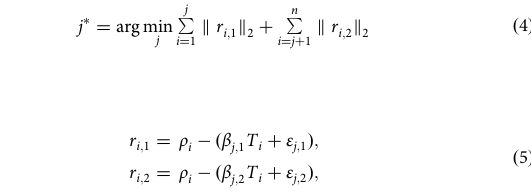
Supplementary Table 1. For the viscosity, a correlation time of 1 ns was used and the simulations were run for 500 ns. Further validation of the force fi eld was done by comparing histograms and RDFs of HDDA to ab-initio based MD as implemented in the CP2K software 62 . The ab initio simulations were performed using the BLYP functional supplemented with D3 dispersion corrections 25,63 . As shown in Supplementary Figs. 1 and 2, the histogram of the dihedral angles of HDDA in liquid state and the end-to-end distance in HDDA are well-captured by the TraPPE-UA force fi eld with a few notable differences. In addition, the RDFs of the 1-1 and 2-2 reactive sites are also well-captured by the employed force fi led in comparison to the ab initio simulations as shown in Supplementary Fig. 3. Curing simulations . We used a simulation protocol that accelerates the curing process by lowering activation energies and increasing temperature to 600 K, which was earlier shown not to affect the structure of the network when considered as a function of bond conversion 15 . The covalent bonds appearing during the curing of the network were created using a reactions cutoff radius of 4 Å . The proximity of reactive sites was checked every 10 fs and a bond was created with probability 0.5 for every time reactive sites within the cutoff radius. After placing a new crosslink, the whole system was equilibrated in the NPT ensemble. The activation energy, which affects the chemical reaction rate, was assumed to be equal for all monomers. Hence, to link the simulation time to the real time, one needs additionally to compensate the contribution of the chemical activation energy. The curing was simulated for up to 100 ns, which is enough for all systems to reach bond con- version of 0.8 in our protocol. This corresponds to 4 weeks of computational time for one trajectory. The curing simulations and the tests for physical properties